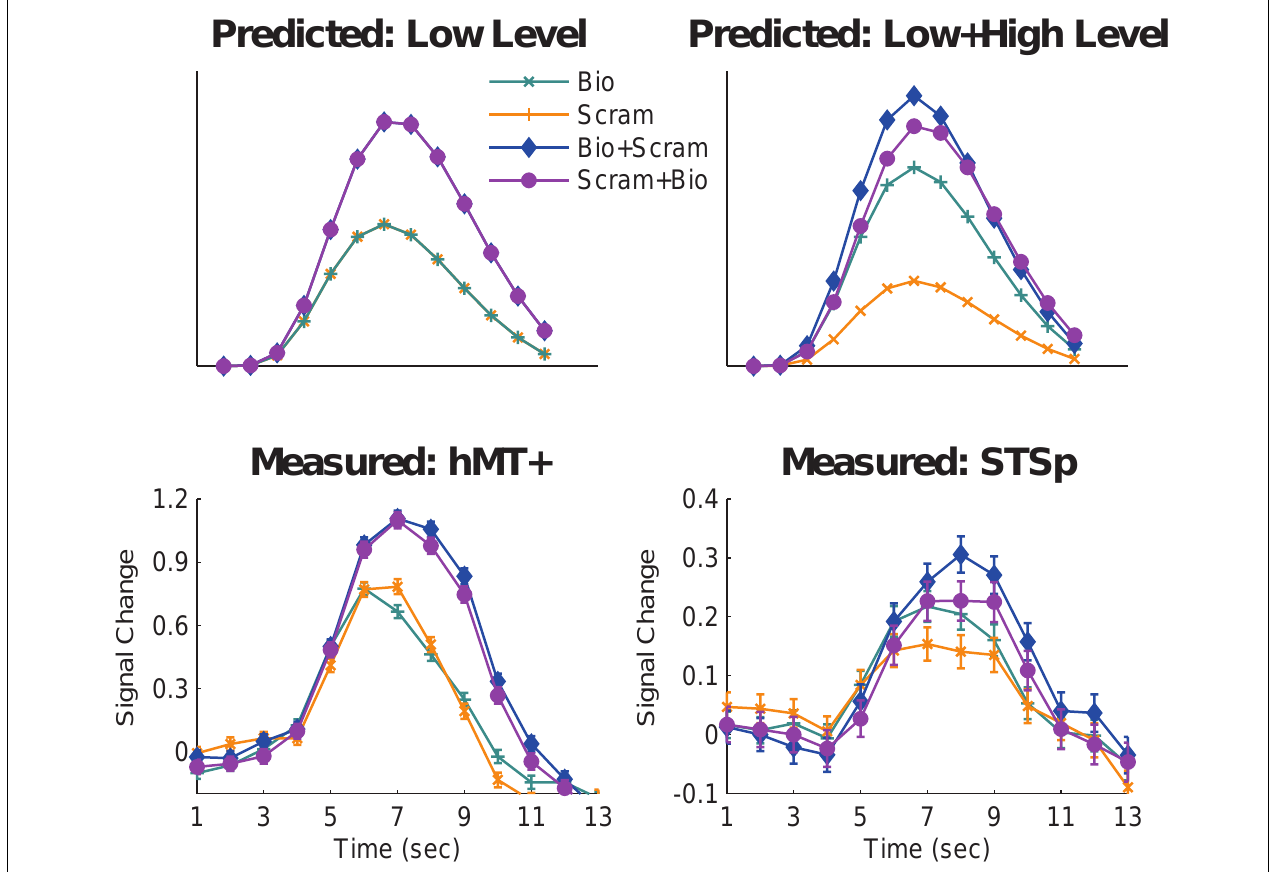
FIGURE 4 | The predicted and measured BOLD responses for the cross- adaptation between biological and scrambled motion (Experiment 2). Top Panel: The predicted BOLD response from a brain area with only “low-level” neurons that are velocity tuned (left), and a mixture of low- and high-level neurons (right). This model predicts the same BOLD response for the single biological and single scrambled trials (orange and green), and an identical BOLD response for the biological + scrambled as the scrambled + biological trials (blue and purple,